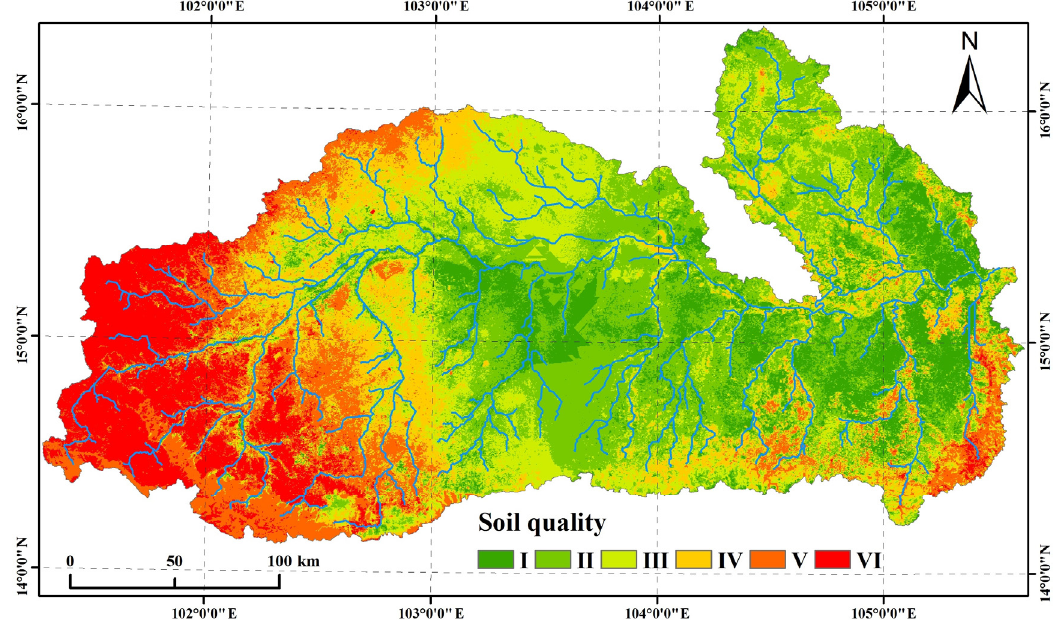
Figure 5. Assessment result of soil quality in the dry season. Table 5. The area of different land-use type in different soil-quality